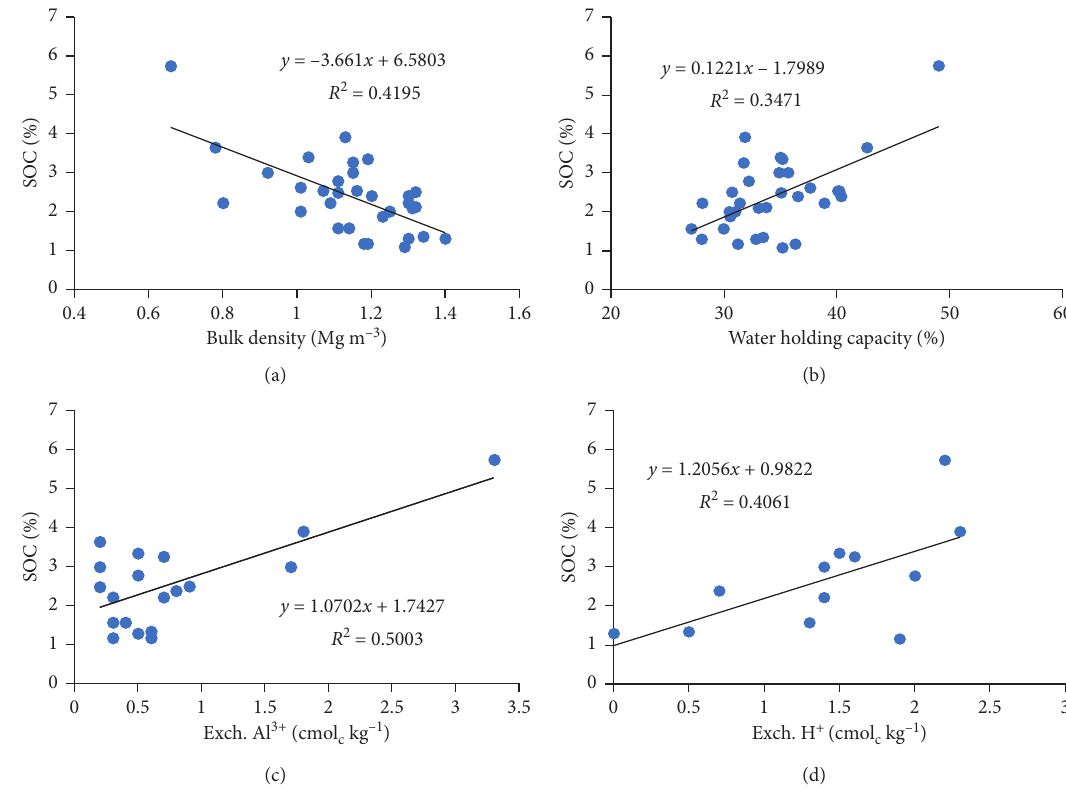
Figure 5: Relationships between SOC content and selected soil properties.